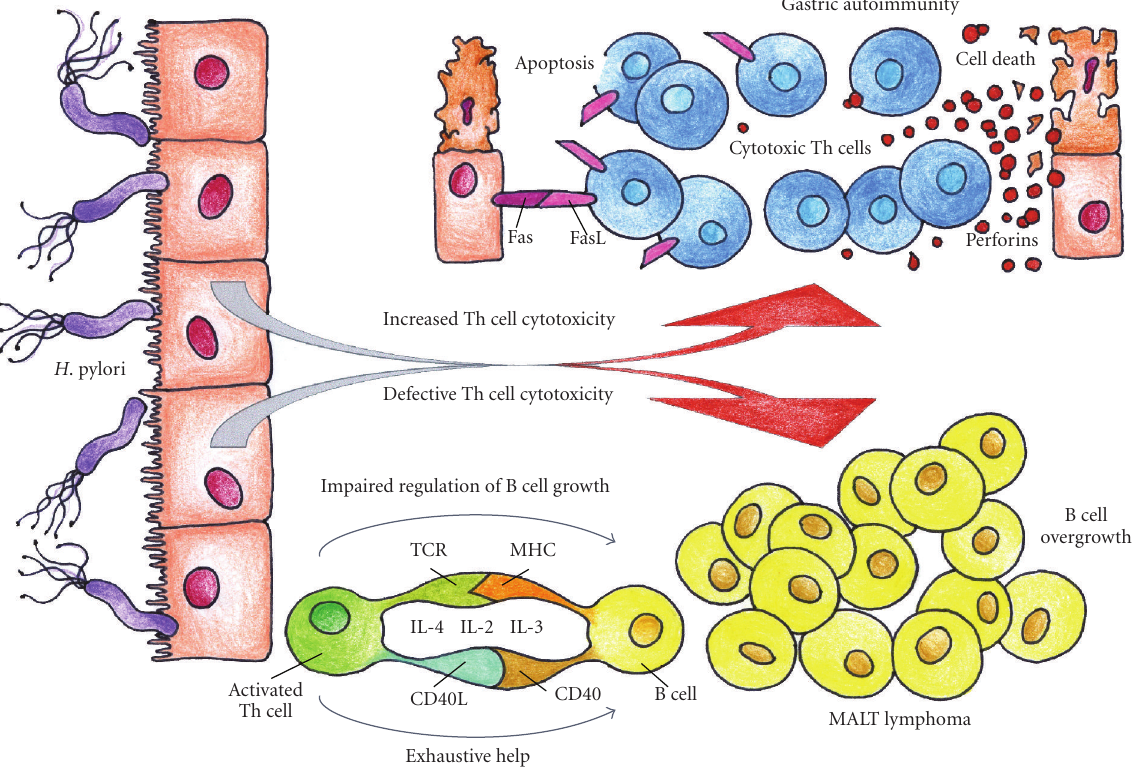
Figure 1: Di ff erent cytotoxic functions of T cells in H. pylori -related gastric autoimmunity and gastric lymphoma. T cells are essential for defence against infection, but inappropriate Th responses can be harmful for the host. In susceptible individuals, H. pylori induces gastric autoimmunity via molecular mimicry by the expansion of H. pylori -specific T cells that cross-react with H + K + -ATPase epitopes. Cross- reactive T cells would result in destruction of gastric mucosa, by the long-lasting activation of both Fas-ligand (FasL)-induced apoptosis and perforin-mediated cytotoxicity. Conversely, in a minority of infected patients, gastric H. pylori -specific Th cells display deficient cytotoxic control (both perforin and Fas-Fas-ligand mediated) of B-cell growth. Such cytolytic defects, associated with the production of cytokines with B-cell growth factor activity and the chronic delivery of costimulatory signals by Th cells, together with chronic exposure to H. pylori antigens, would result in overgrowth of B cells, thus promoting the neoplastic B-cell transformation and the onset of gastric low-grade MALT B-cell